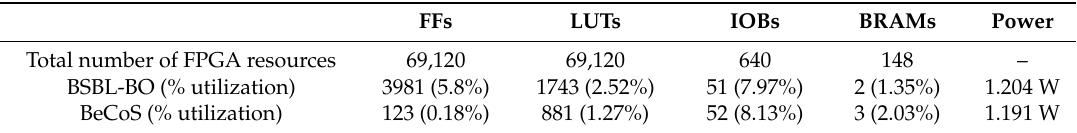
Table 3. Comparison of the power and FPGA resource utilization for the BSBL-BO and BeCoS core engines. FFs LUTs